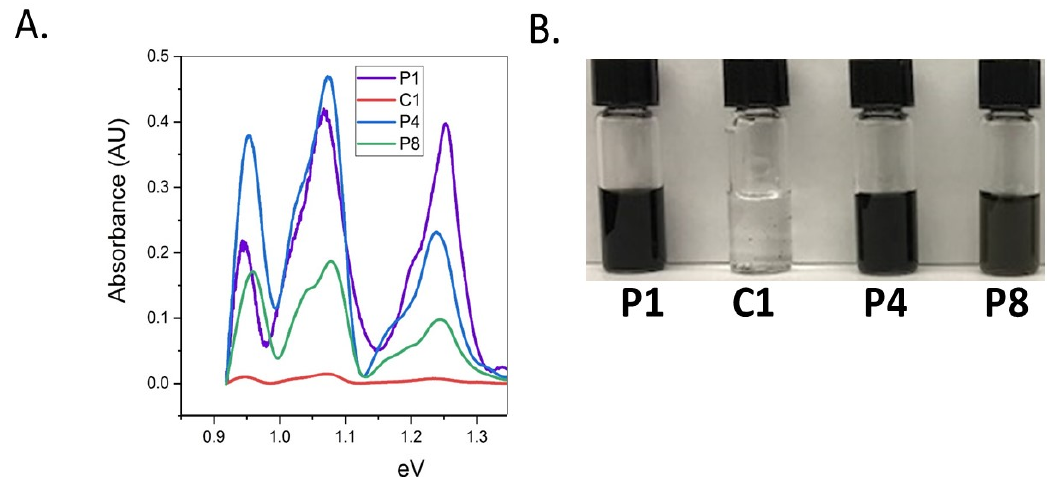
Figure 2. ( A ) Absorption spectra of CNT–peptide dispersed solutions and ( B ) optical micrograph of aqueous dispersion of HiPCO CNT dispersion obtained from the peptides identified by literature (P1 peptide), non-HTS method (C1) and NHTS–PD method (peptide P4 and P8).